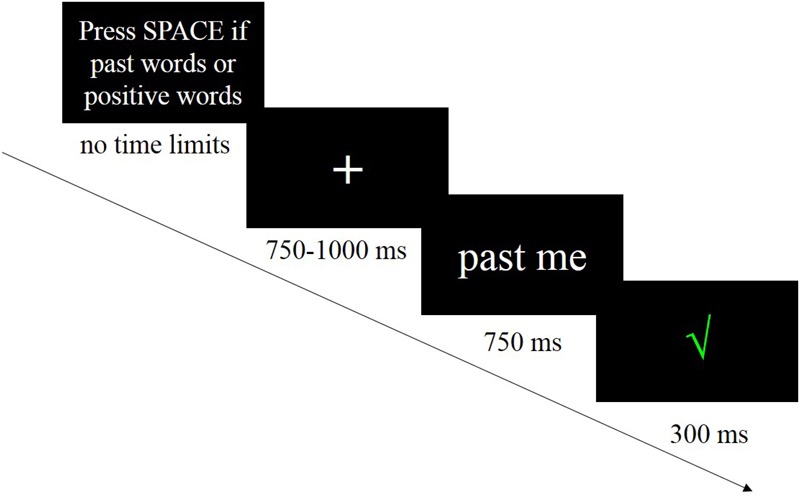
A trial in one of the six blocks. After understanding the instruction in this block, participants started the trials. A total of 40 trials in each block.